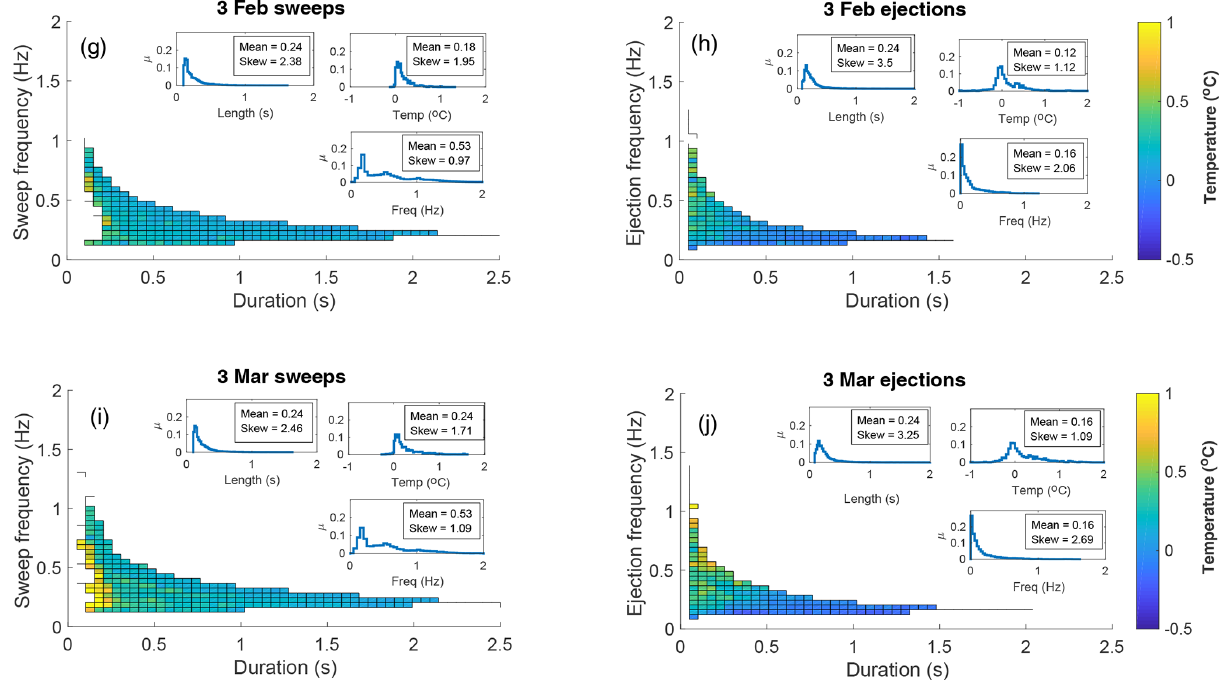
Figure 3. Bin-averaged temperature fluctuations of near-surface anemometer from the 15min mean for events of specific return frequency and event duration for recordings over each blowing snow storm. Insets are plots of probability distribution functions of event duration, temperature deviation, and event frequency for each storm and type of event.